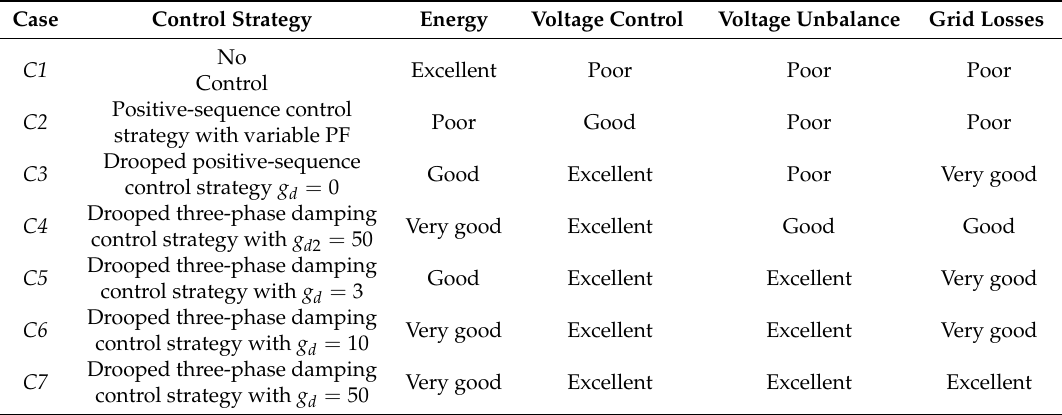
Table 2. Comparison table of the performance of the different control